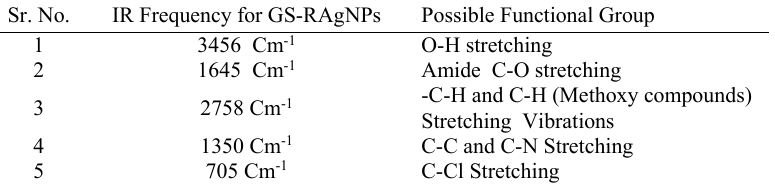
C-Cl Stretching Fig. 4 (b): IR Spectra of RWE and